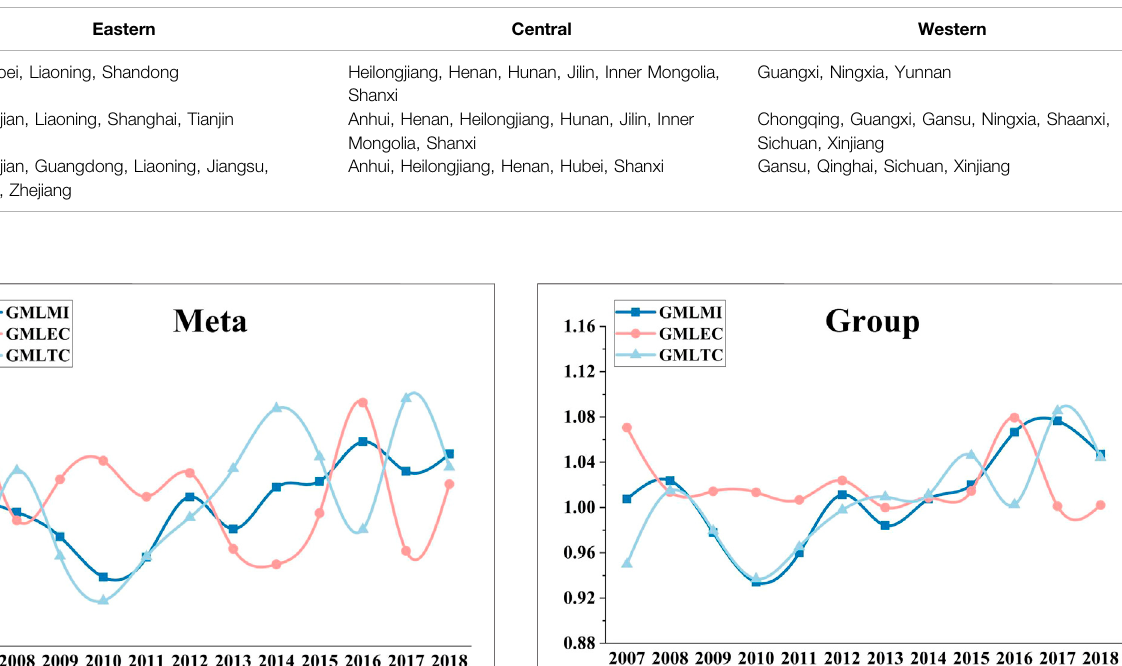
TABLE 3 | Descriptive statistics of a variable.